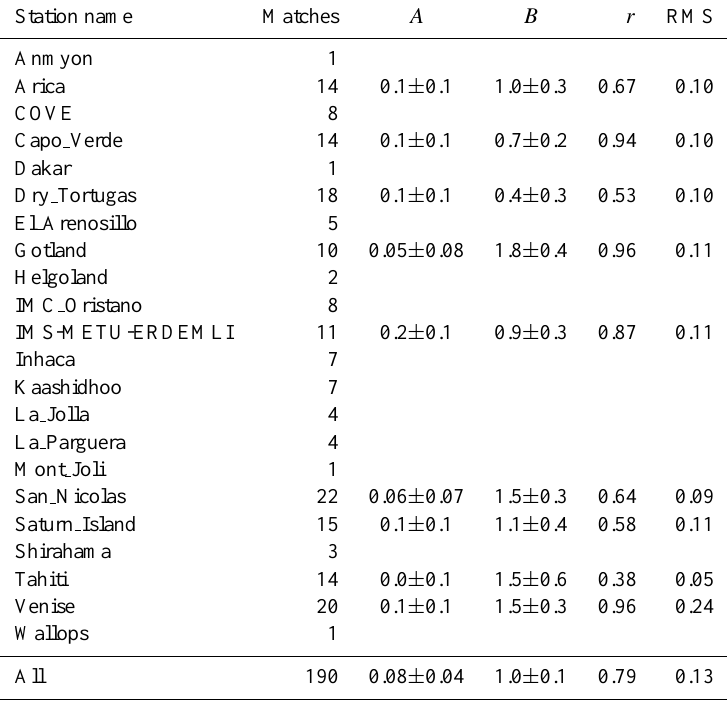
Table 3. Statistics of comparisons between GRAPE and AERONET 550nm AODs for each AERONET station. The values A and B are the coefficients of a weighted linear least squares fit like that shown in Fig. 3, such that τ g = A + Bτ A . r is the Pearson correlation coefficient and RMS is the root-mean-squared difference between the two data sets. Statistics are omitted for sites for which there were less than 10